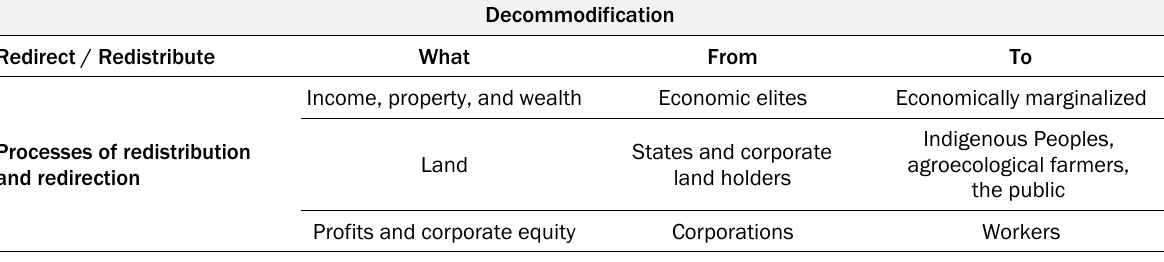
Table 5. Examples of Redistributive Policies for